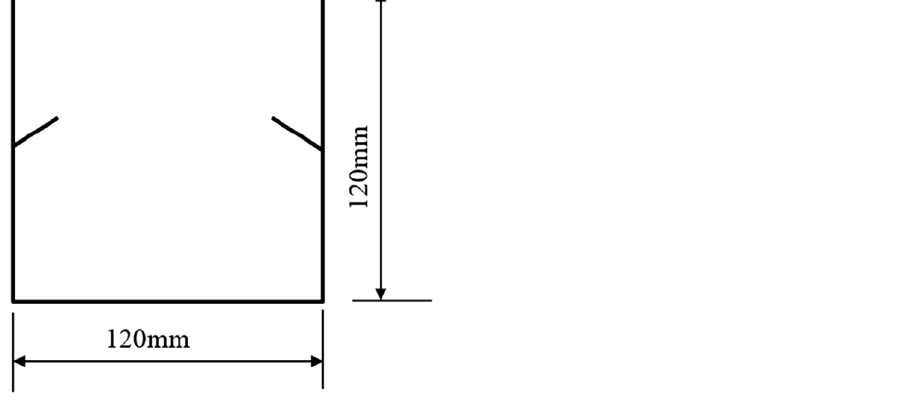
Figure 10. Precast crack orientation 7. Fissure length 2 cm, horizontal angle of fissure